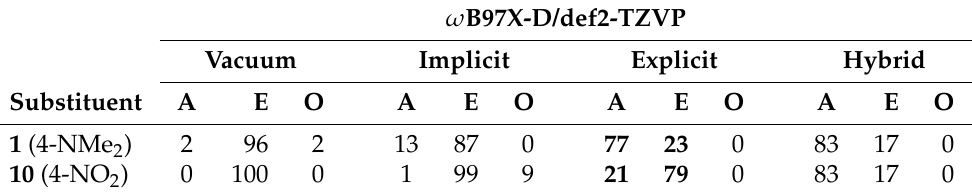
Table 2. The percentage fraction of the different tautomers of 1 and 10 in the mixture from the theoretical DFT calculations (boldfaced is the best correspondence between the experiment presented in Table 1 and the theoretical estimation). ω